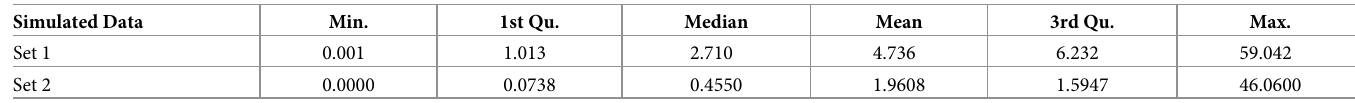
Table 1. The summary measures of the simulated data sets. Simulated Data Min.